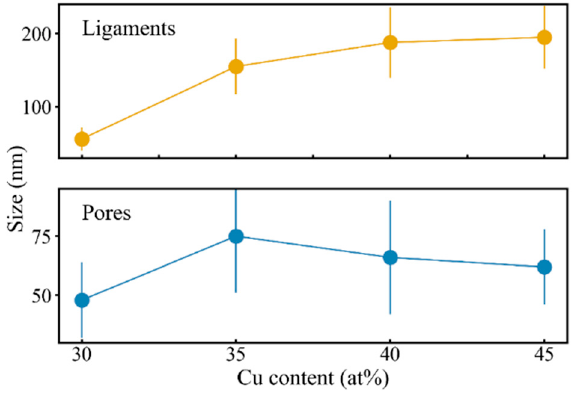
Figure 9. Average ligament and pore sizes as function of copper content for Cu 30 Mg 25 Ca 45 , Cu 35 Mg 25 Ca 40 , Cu 40 Mg 25 Ca 35 , Cu 45 Mg 25 Ca 30 dealloyed in 0.04 M H 2 SO 4 .